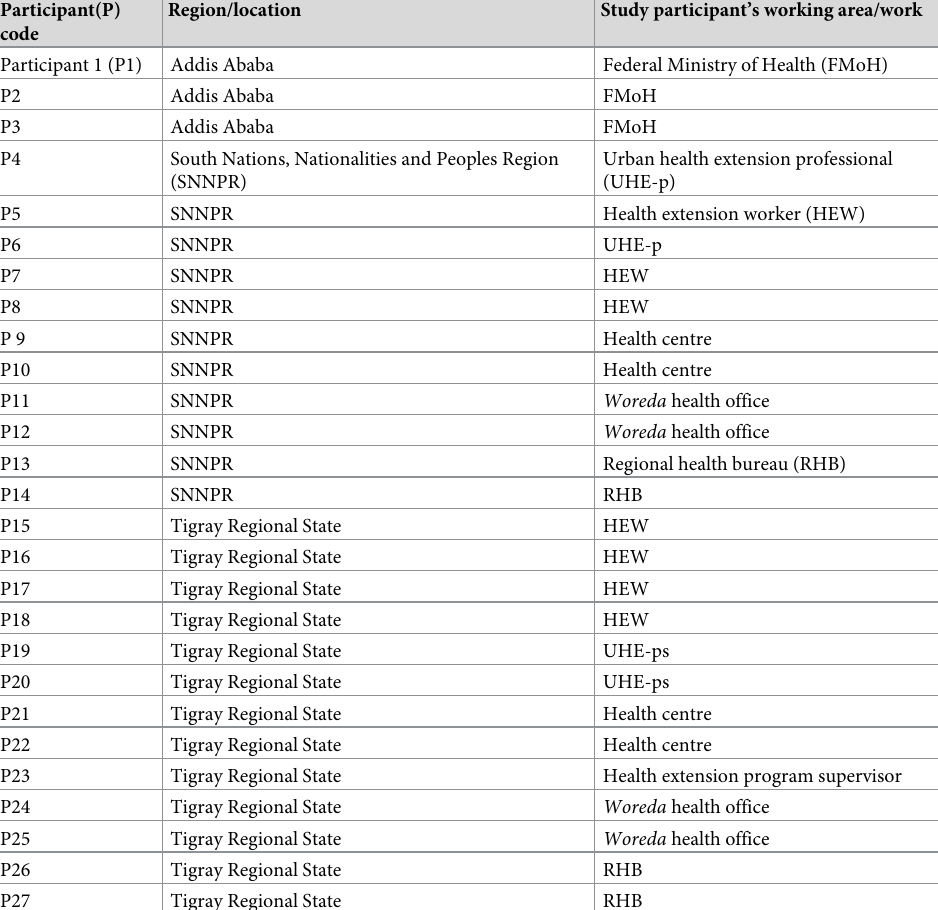
Table 1. Characteristics of study participants, Ethiopia,